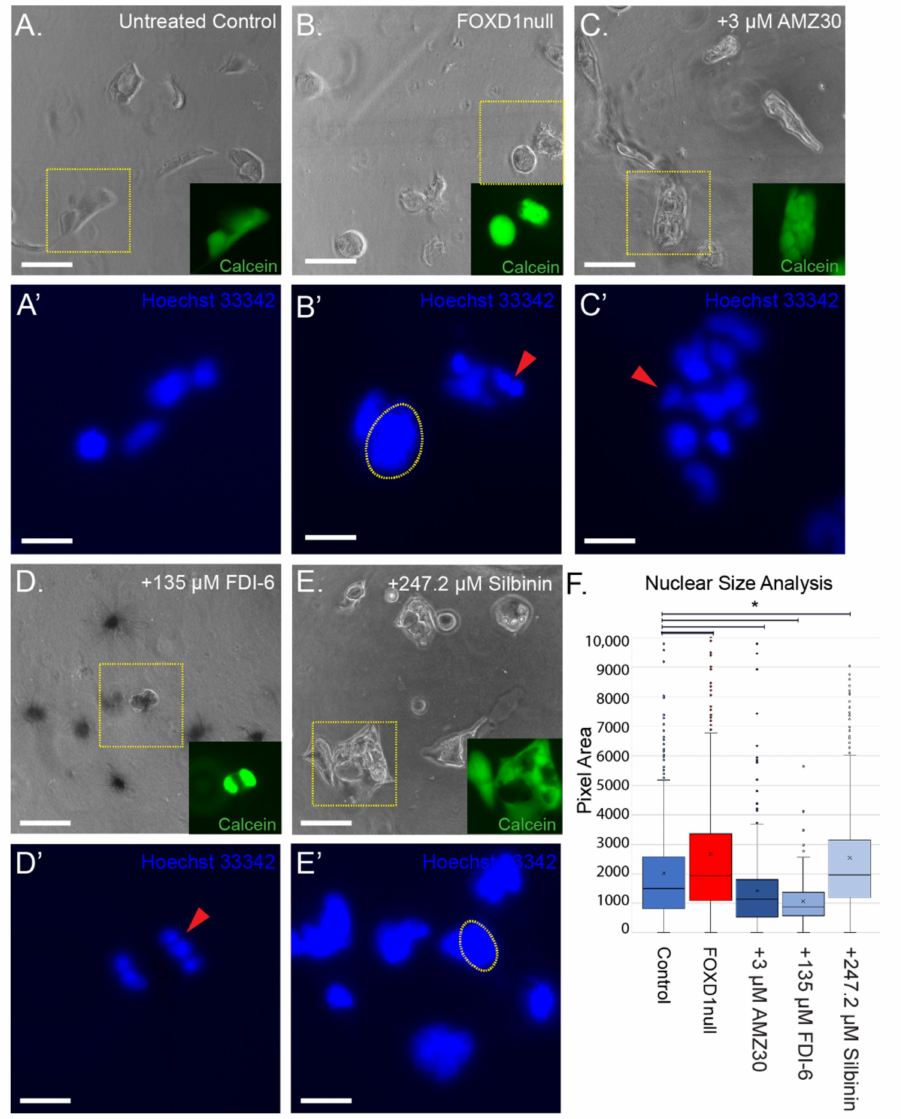
Figure 7. Effects of candidate compounds on nuclear structure in 786-O tumor cells grown in 3D culture. ( A – E ) images of 3D cultures treated with each candidate compound. Yellow box shows representative cell colony and inlay shows Calcein-AM (green) staining of that colony. Scalebar = 100 microns. ( A’ – E’ ) Hoechst 33,342 nuclear staining of cell colonies in yellow boxes in ( A – E ). Yellow- dotted outlines highlight enlarged nuclei. Red arrows indicate nuclear defects causing reduced nucleus size. Scalebar = 20 microns. ( F ) quantification of nuclear size in each treatment. * = p < 0.05 by Z-test. X = median, line through box = average. Circles outside the box are